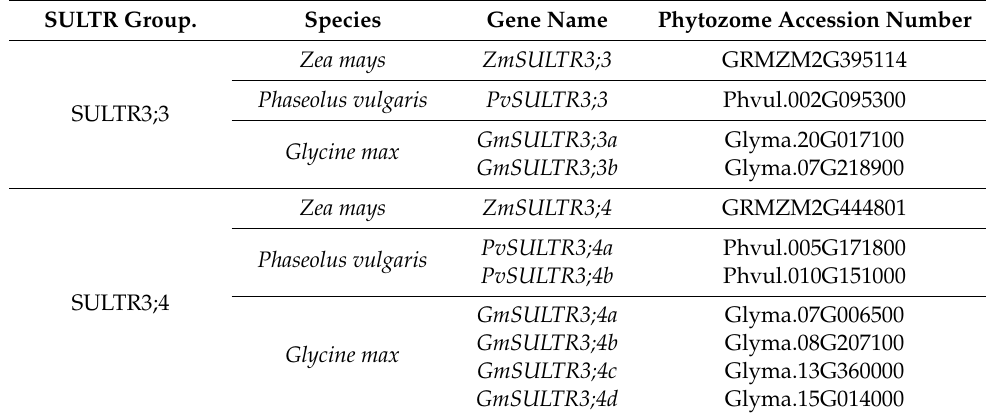
Table 2. Putative orthologous genes of OsSULTR3;3 / HvSULTR3;3 and OsSULTR3;4 , identified in maize, common bean, and soybean by in silico